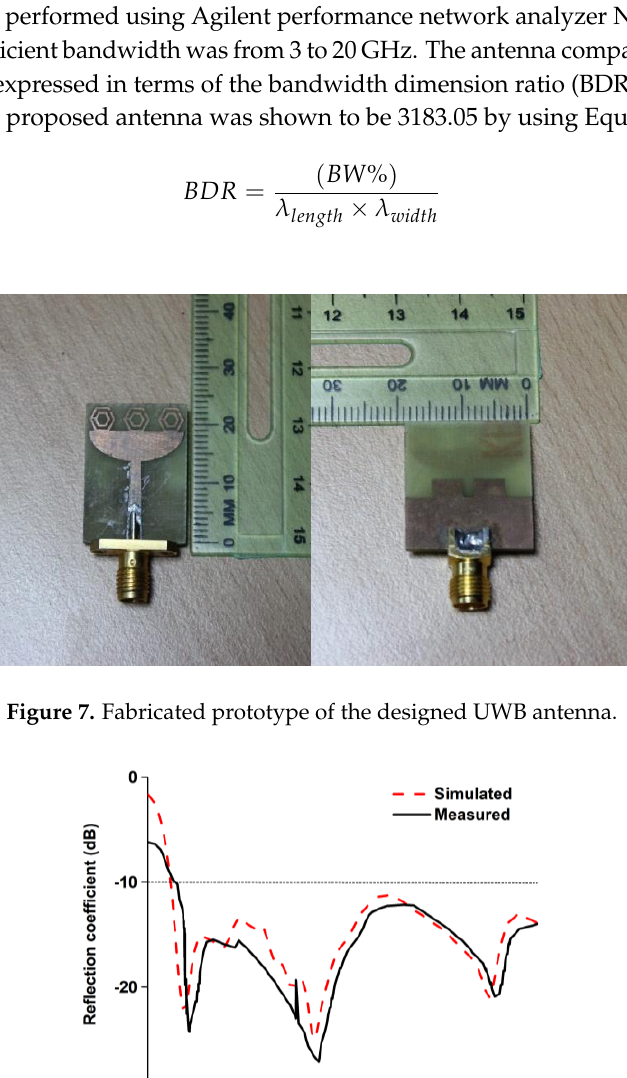
Figure 9. Antenna radiation characteristics measurement setup. ( a )